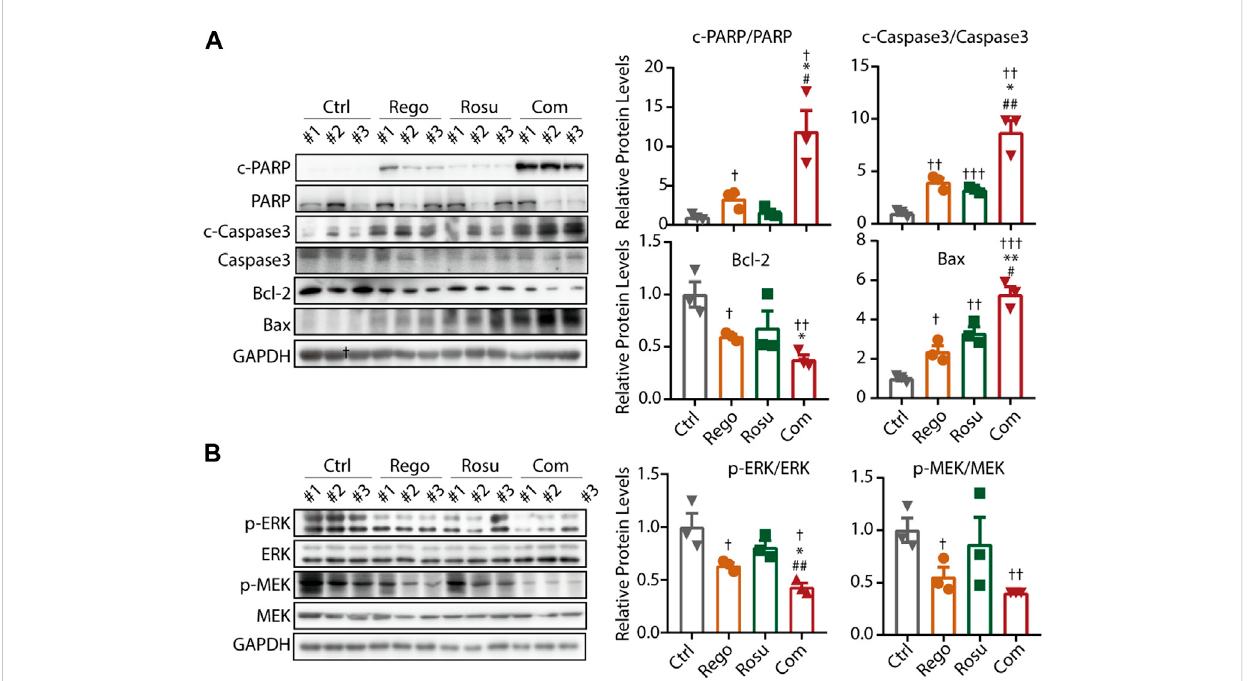
FIGURE 5 Regorafenib and rosuvastatin co-treatment synergistically suppressed MAPK signaling and promoted apoptosis of colorectal cancer in vivo . (A) Immunoblotting analysis to examine intratumor c-PARP/PARP expression levels of MC38 tumors. (B) Immunoblotting analysis to examine intratumor p-ERK/ERK expression levels of MC38 tumors. The data are shown as mean ± SD, n. s, no sense, † /*/#, p < 0.05; †† /**/##, p < 0.01; ††† , p < 0.001 ( † : vs . Control group; *: vs . Regorafenib group; #: vs . Rosuvastatin group). Rosu: Rosuvastatin; Rego: Regorafenib; Com: